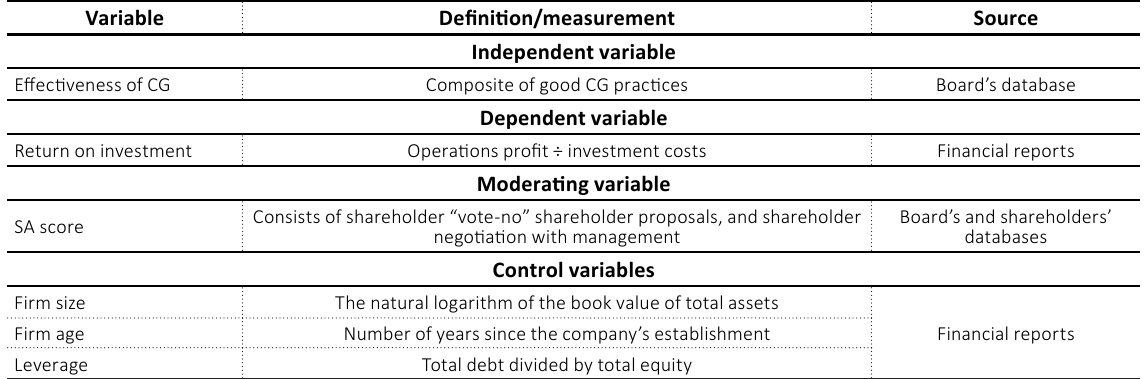
Table 1. Definitions/measurement of the variables and data sources